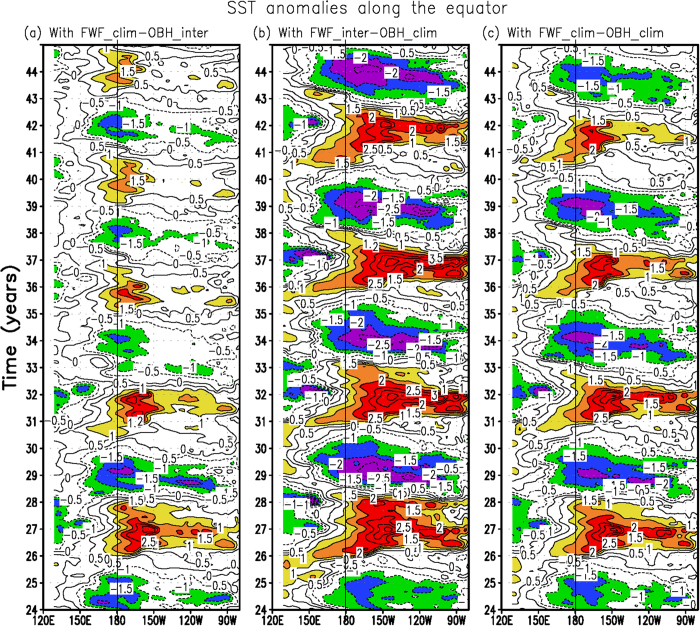
Interannual SST anomalies along the equator simulated in (a) FWFclim-OBHinter, (b) FWFinter-OBHclim, and (c) FWFclim-OBHclim. The contour interval is 0.5 °C.